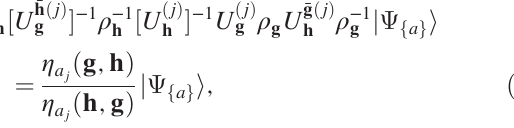
FIG. 3. Anyonic flux per unit cell b ð T